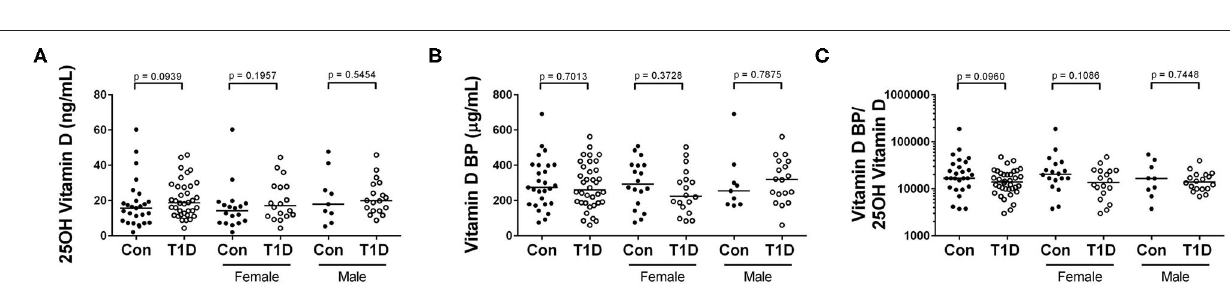
FIGURE 5 | 25(OH) vitamin D and vitamin D BP levels are similar between control and T1D subjects. (A,B) We observed no difference in abundance of 25-hydroxy vitamin D (25(OH) vitamin D) nor vitamin D binding protein (BP) among T1D subjects and control. (C) Additonally, the ratio of vitamin D BP to 25(OH) vitamin D was similar among the two groups (C) . Bars represent median